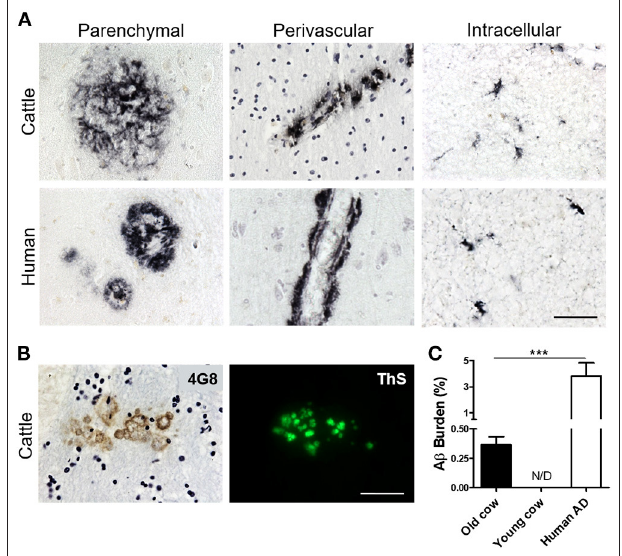
FIGURE 1 | Accumulation of A β deposits in aged cattle brain. (A) Histological analysis of the brain of old cattle (top panels) showed the presence of diverse types of A β − immunoreactive lesions, including parenchymal amyloid plaques (left), perivascular deposits (center) and intracellular aggregates (right). These deposits were similar to those observed in patients affected by AD (bottom panels). Staining was done using the 4G8 anti-A β antibody in sections of the temporal area. (B) The parenchymal deposits were also ThS-positive when stained in the consecutive slide, showing that cattle aggregates also acquire fibrillar structure. (C) Histology data was analyzed to quantify the A β burden, defined as the percentage of the brain area occupied by A β − reactive deposits. Data represent the mean ± standard error of the mean and differences were analyzed by an unpaired student T-test ( p < 0.001, N = 5–14). Scale bar in (A) and (B) corresponds to 50 µ m. *** p <